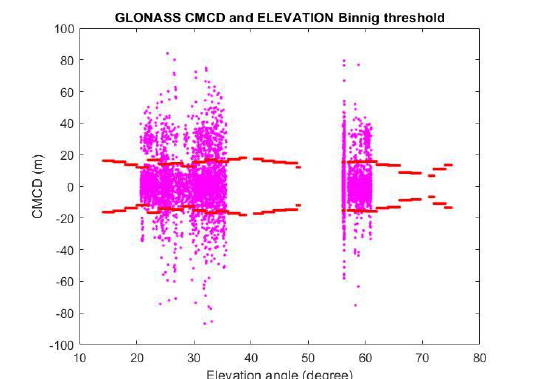
Figure 5. Coloured dots that bigger or smaller values than red values are accepted as GLONASS CMCD measurements (Magenta dots are GLONASS CMCDs and red lines are acceptable threshold)